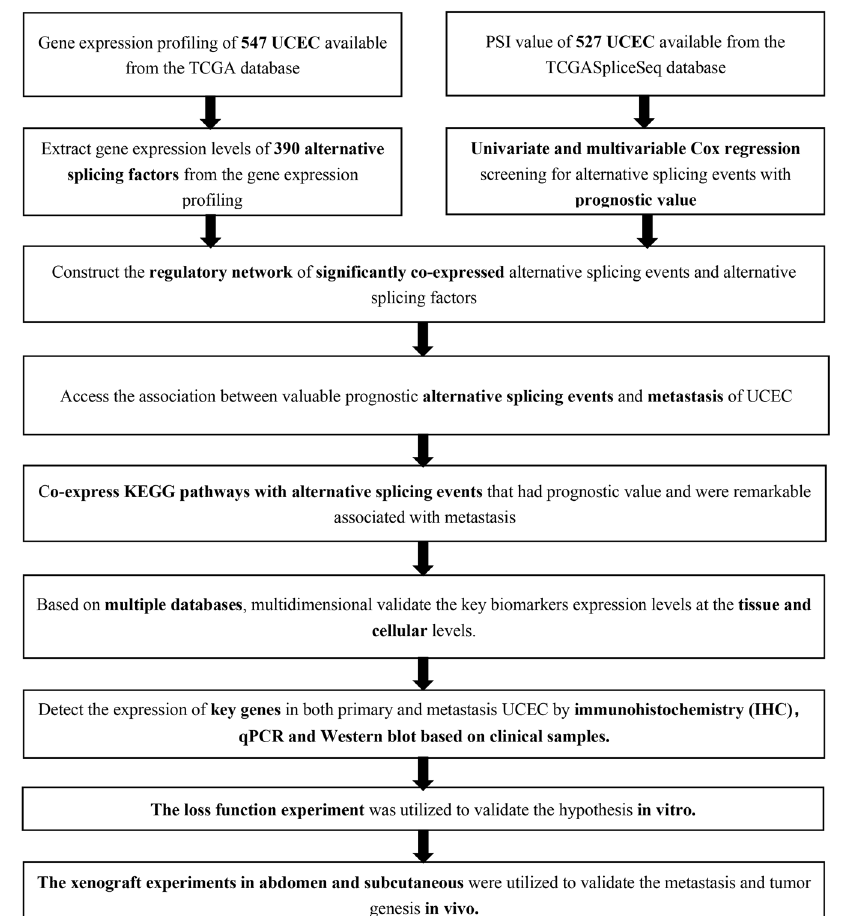
Fig. 1 Analysis process presentation. The fl ow chart of the analysis process (a). Table 1. Baseline information of 547 patients diagnosed with uterine corpus endometrial carcinoma is available from the